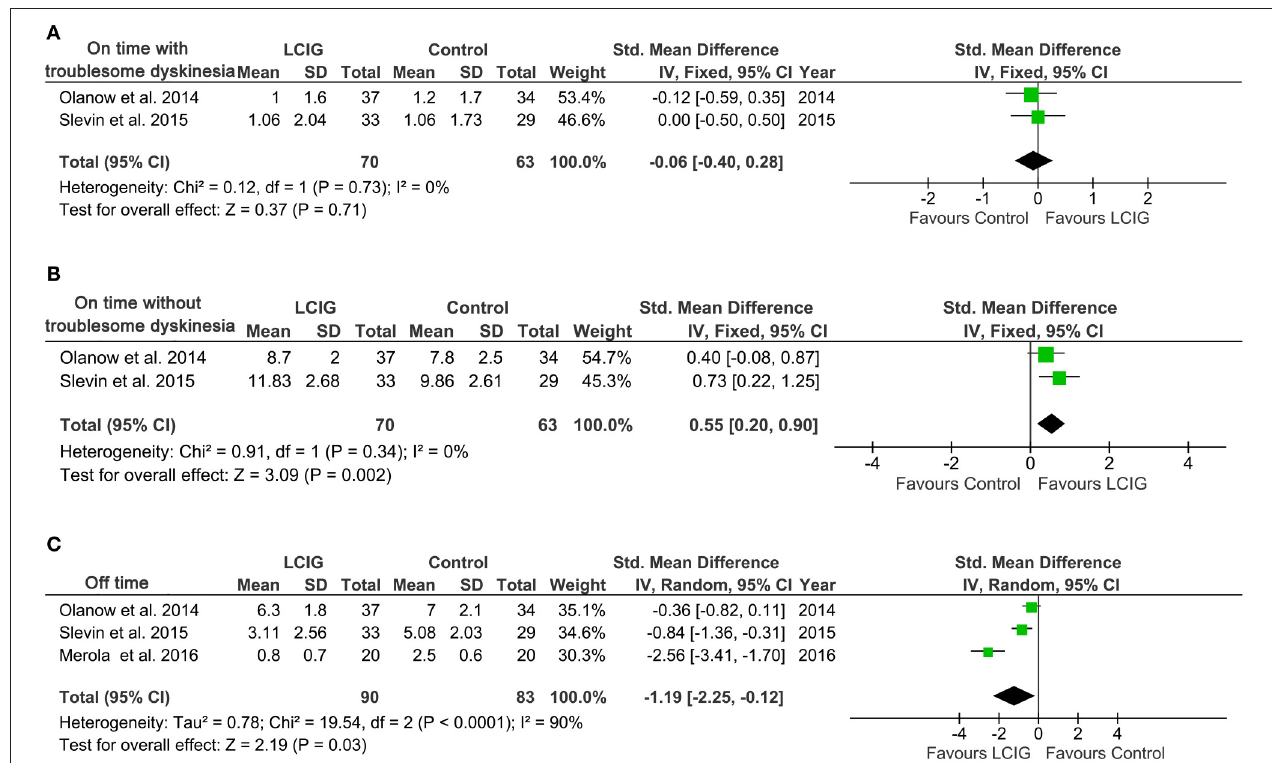
FIGURE 2 | Forest plots of pooled on-time and off-time in PD patients. Plot A (A) , on-time with troublesome dyskinesia, h per day; plot B (B) , on-time without troublesome dyskinesia, h per day; plot C (C) , off-time, h per day. PD, Parkinson’s disease; LCIG, levodopa-carbidopa intestinal